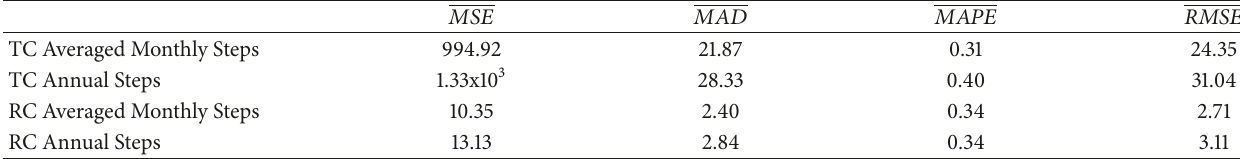
Table 6: Average for main measures of error for GBM after 1000 MC simulations for 2013-2014.